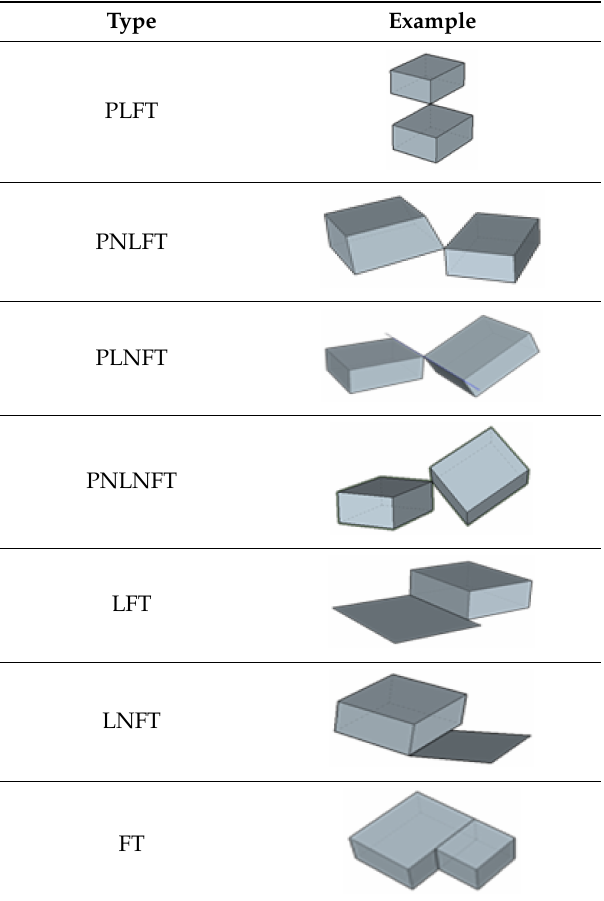
Table 3. The touch topological relation for objects in a 3-D